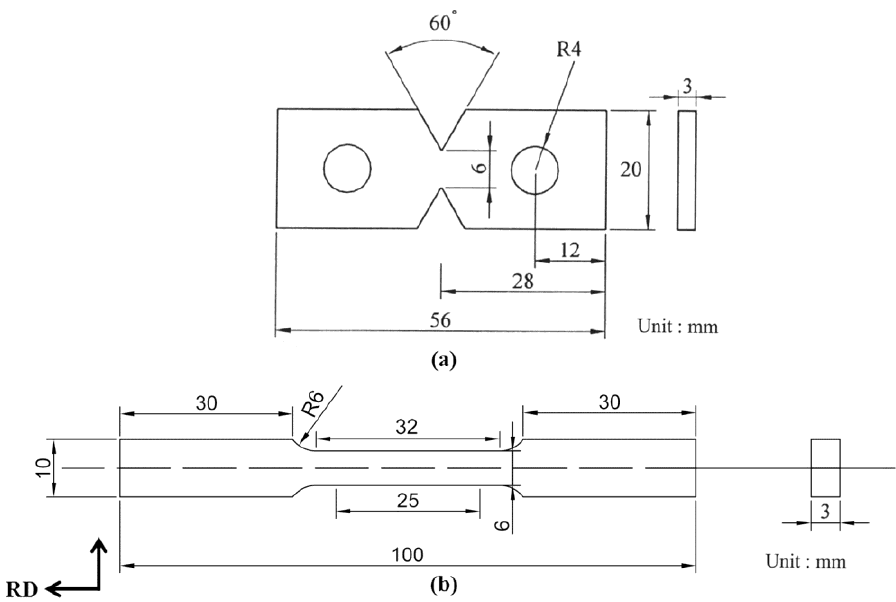
Figure 1. Schematic dimensions of ( a ) a double-edge notched specimen and ( b ) a standard tensile specimen. (RD: Rolling Direction).